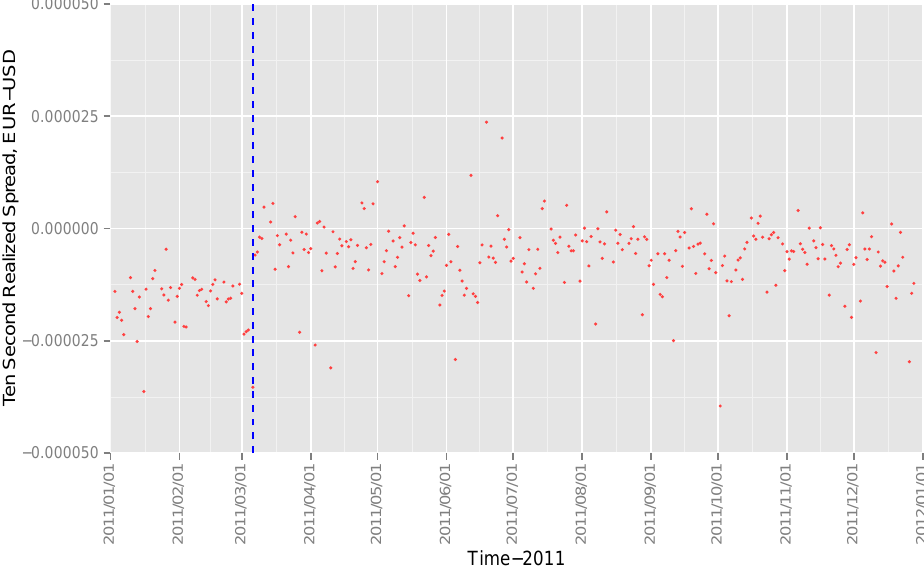
Figure 13. EUR/USD Realized Spread, Ten-Second Frequency.